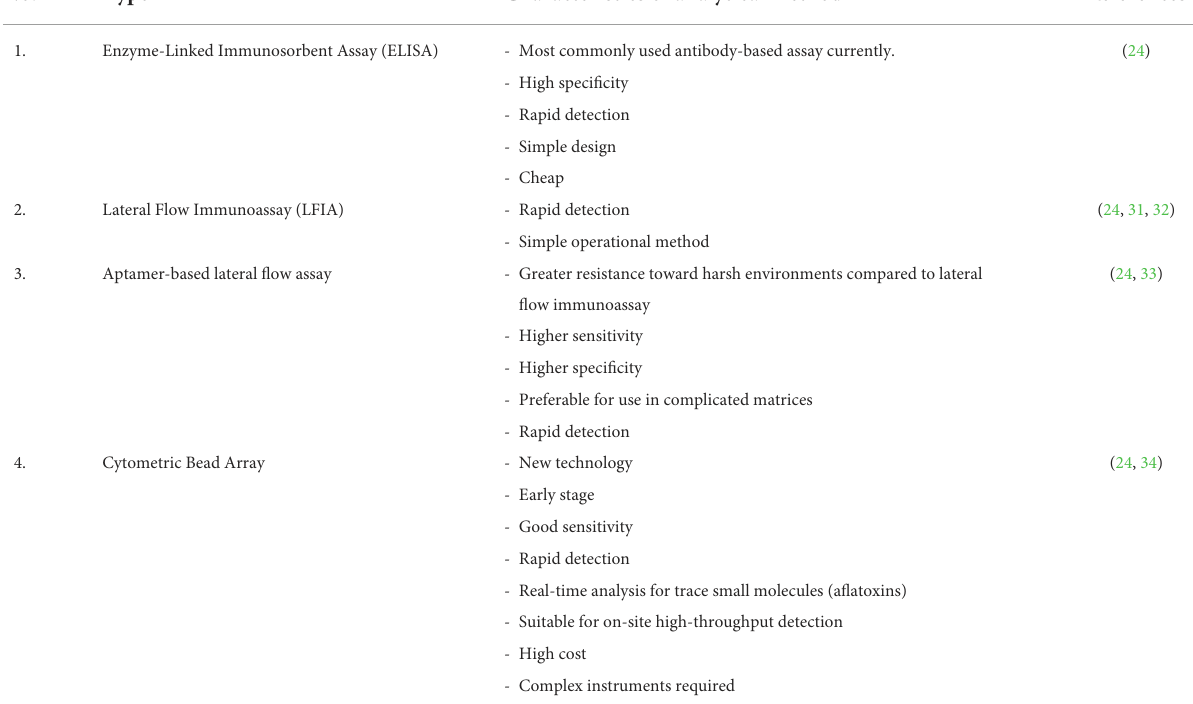
TABLE 3 Analysis of rapid screening techniques used in aflatoxin